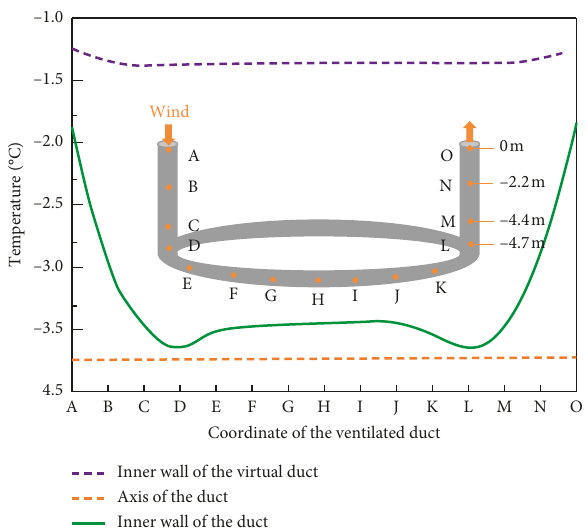
Figure 3: Annual mean temperature at the axis and inner wall of the duct (virtual duct).